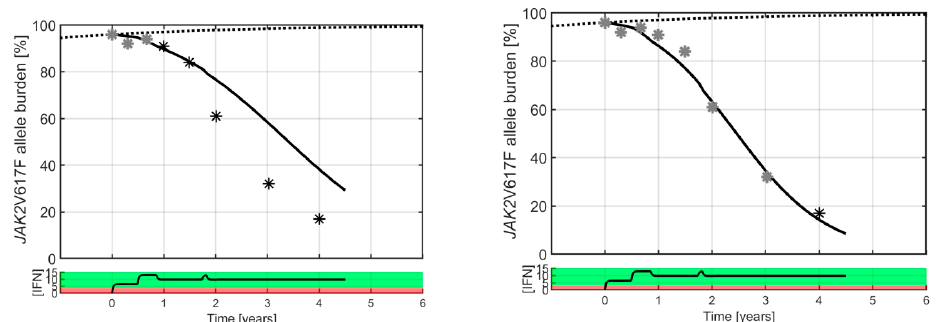
Figure 3. A typical good responder is shown with a high baseline value (50% JAK2 V617F allele burden). Black and grey stars are clinical measurements, whereas the full curves are model predictions. The dotted curve is a sigmoidal increasing “population” master curve corresponding to unperturbed disease growth. Grey data points are used to calibrate the Cancitis model for personalized prediction, and the black data points are the clinical measurements used for validation. Generally, three data points for calibrating the model provide good predictions, but increasing the number of data points increases the accuracy of the predictions. A curve generated by a pharmacokinetic model displays the daily average IFN dose in µg in black in the bottom panel (see Supplementary Material A). The red dose–response region indicates the dosing value of poor individual response, and the green dose–response region indicates the dosing value of good individual response, hence the separation between the two represents the effect threshold for the particular patient shown. A catalogue of all model predictions based on the various numbers of visits to the clinic for each patient can be found in Supplementary Material B.